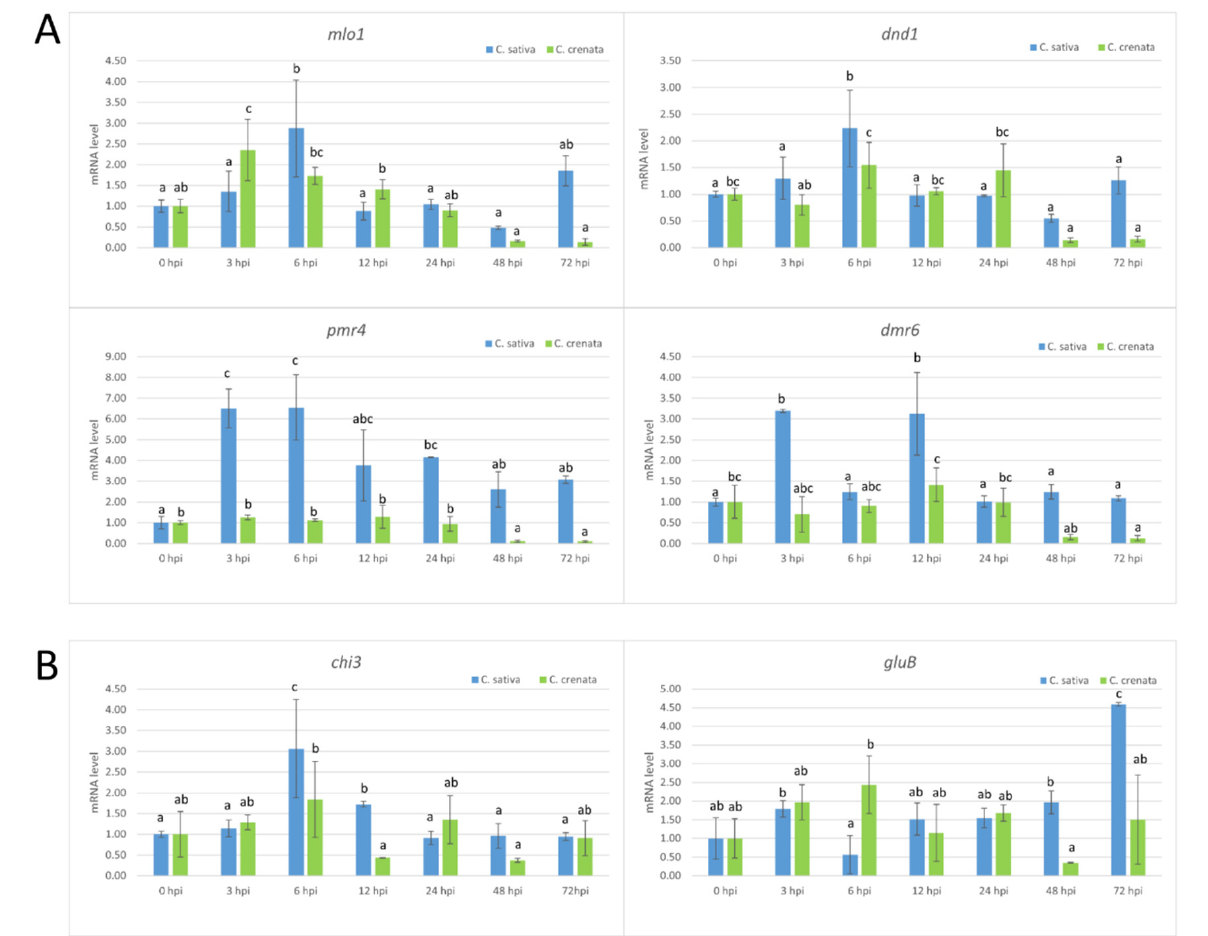
Figure 5. qRT-PCR-based transcription profiling after P. cinnamomi inoculation. ( A ) The S-gene transcription profiles in C. sativa (blue) and C. crenata (green) chestnut species. ( B ) The expression analysis of genes coding for several pathogenesis- related (PR) proteins in C. sativa (blue) and C. crenata (green) species. In all analyses, Cm7-actin was used as a housekeeping gene. Data are the means of three biological replicates ± SE. C. sativa data are normalized with C. sativa 0 hpi control; C. crenata data are normalized with C. crenata 0 hpi control. Different letters associated with the set of means indicate a significant difference based on Tukey’s HSD test ( p ≤ 0.05).